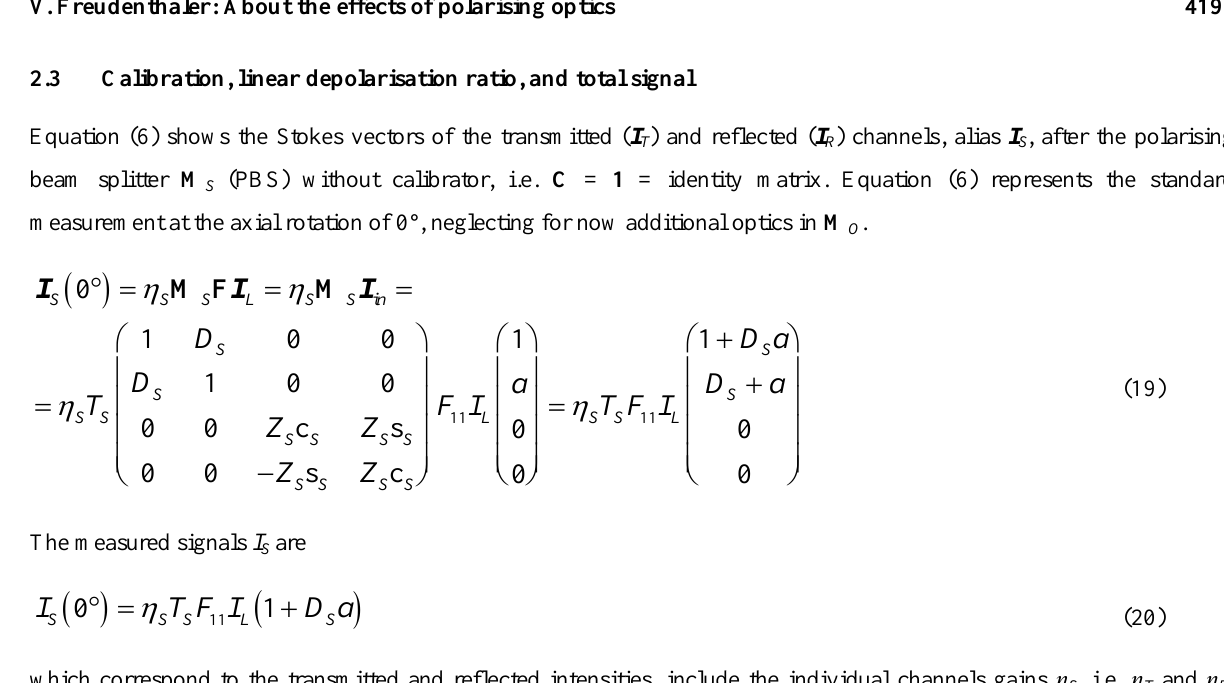
, i.e. η and η , S T R